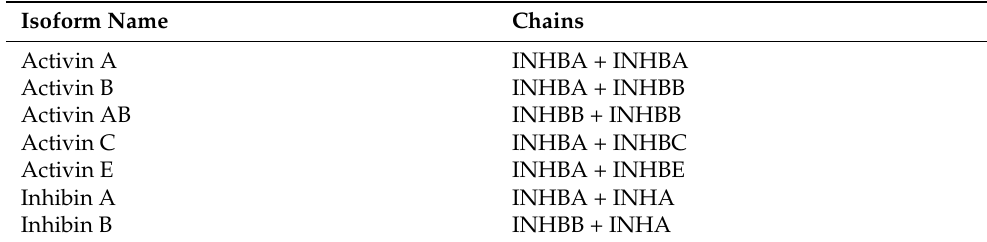
Table 2. Known isoforms of activins and